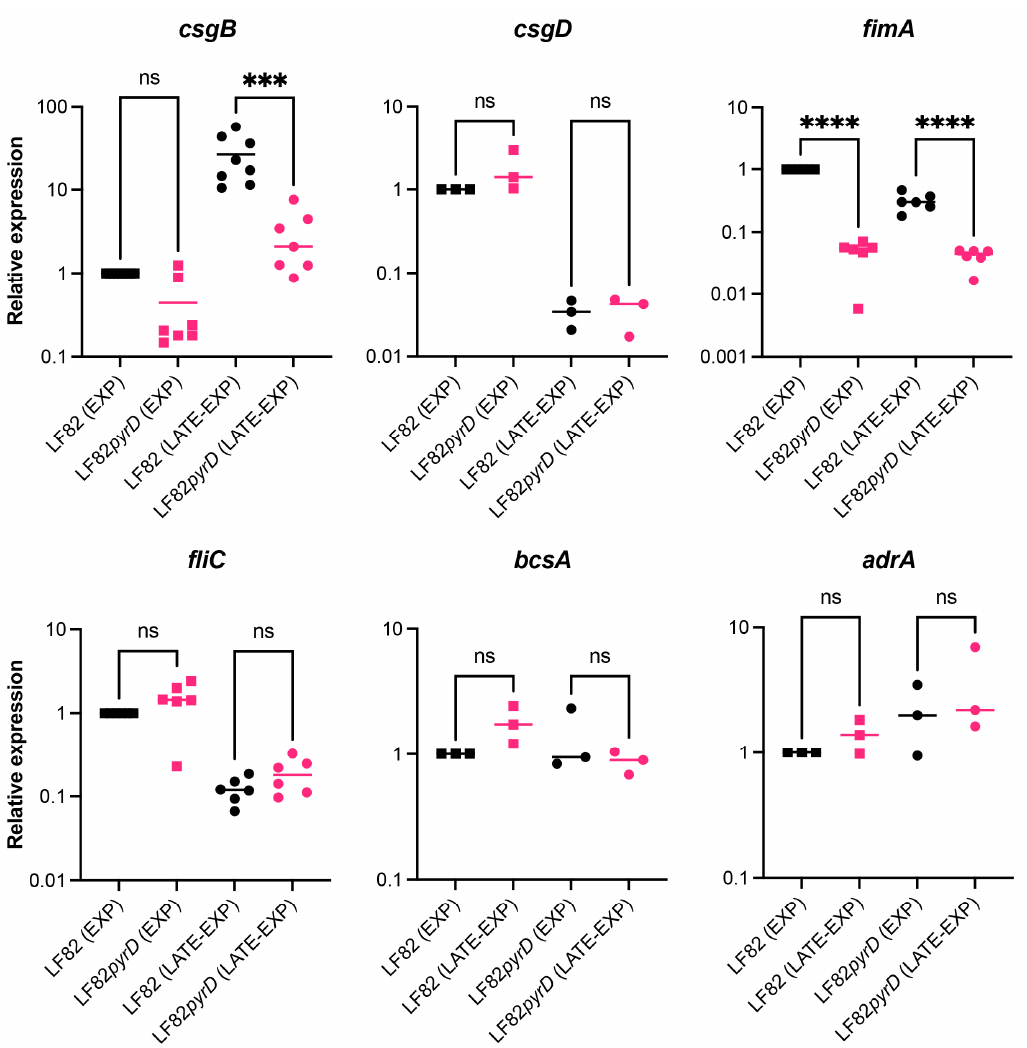
Figure 3. Determination of gene expression levels in the LF82 vs. the LF82 pyrD:: Tn5 (LF82 pyrD ) strain by qRT-PCR. RNA was extracted from bacterial cultures grown in YESCA medium at 30 °C either during exponential growth (EXP, OD 600nm = 0.4) or transition to stationary phase (LATE-EXP, OD 600nm = 1.0). Values are expressed as arbitrary units; transcription levels in the LF82 strain during exponential growth are set to 1. Data are from at least three independent experiments and median are shown. ns, not significant; ***, p -value < 0.001, ****, p -value < 0.0001 One-way ANOVA with Tukey’s test for multiple comparisons.